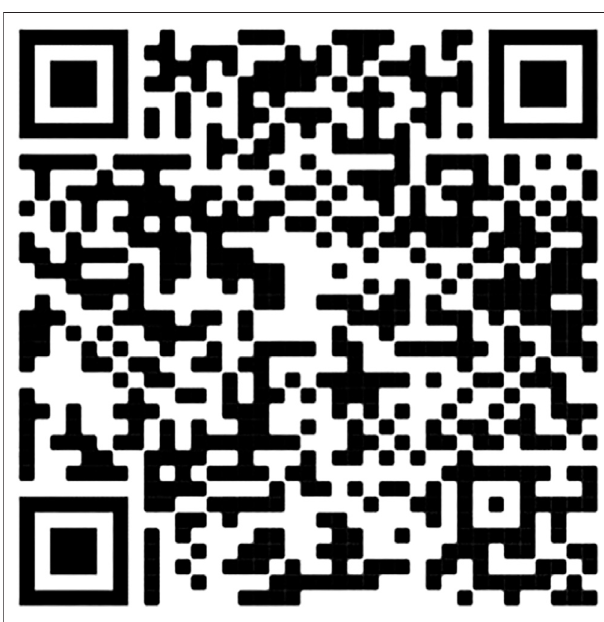
FIGURE 4 | QR code for accessing the questionnaire about the virtual